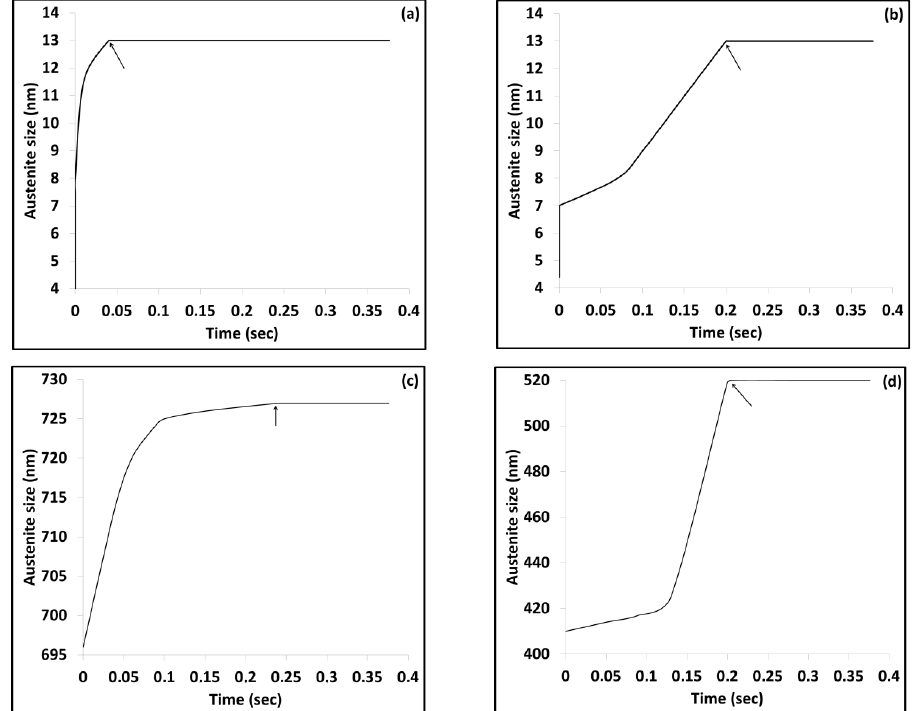
Figure 16. Graphs showing the completion of α → γ transformation for ( a ) fine cementite, ( b ) fine M 7 C 3 carbide, ( c ) coarse cementite, ( d ) coarse M 7 C 3 carbide. The arrow in each case indicates the α to M 7 C 3 carbide; ( c ) coarse cementite; ( d ) coarse M 7 C 3 carbide. The arrow in each case indicates the α to γ transformation. γ